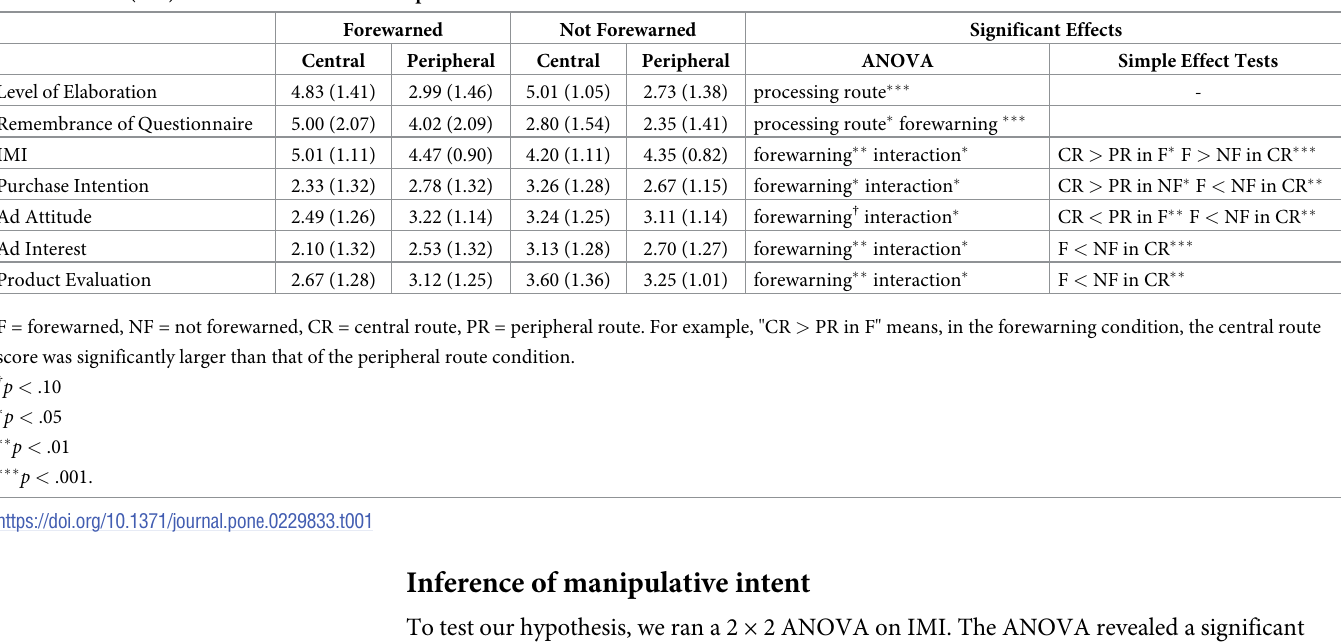
Table 1. Means (SDs) and ANOVA results of manipulation checks and ad evaluations.